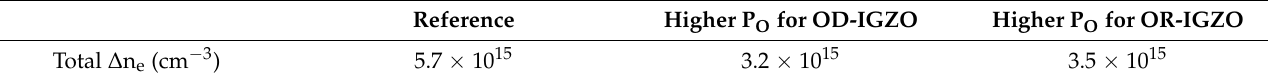
Figure 6. The simulated ∆ n e distributions in DSCL with varying depth for the cases of ( a ) increasing P O for OD-IGZO and ( b ) increasing P O for OR-IGZO. Table 4. Total net photogenerated electron concentration of the DSCL ‐ TFTs.